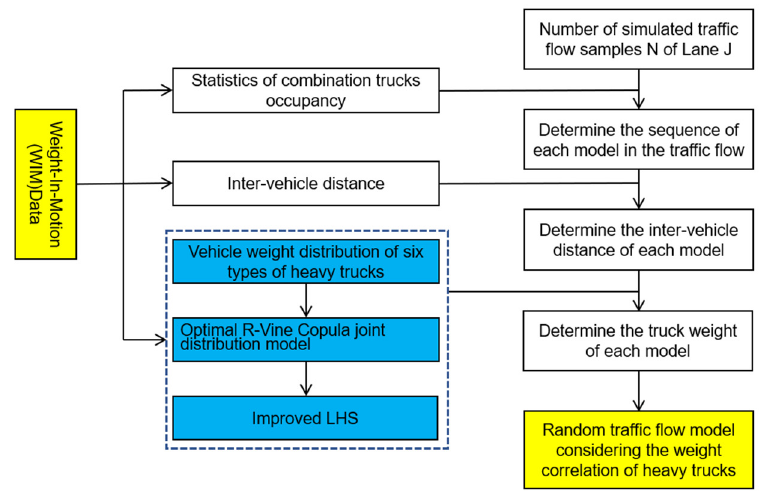
Figure 7. Flow chart of the heavy vehicle random traffic flow model. Table 5. Total weight of each vehicle in traffic.